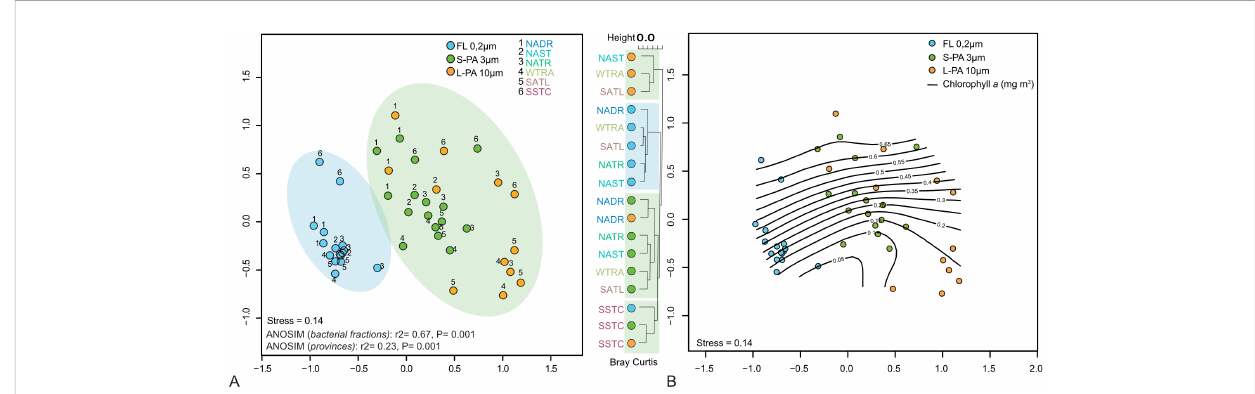
FIGURE 6 NMDS plots of 16S tag data showing bacterial communities sampled during the AMT22 cruise in 2012. (A) Communities clustering into signi fi cantly different groups of free-living (FL, blue background) and a small and large particle-attached (S-PA, L-PA, green background) fraction. (B) Communities shown across chlorophyll a as isotherm. NADR North Atlantic Drift, NAST North Atlantic Subtropical, NATR North Atlantic Tropical Gyre, WTRA Western Tropical Atlantic, SATL South Atlantic Gyre, and SSTC South Subtropical